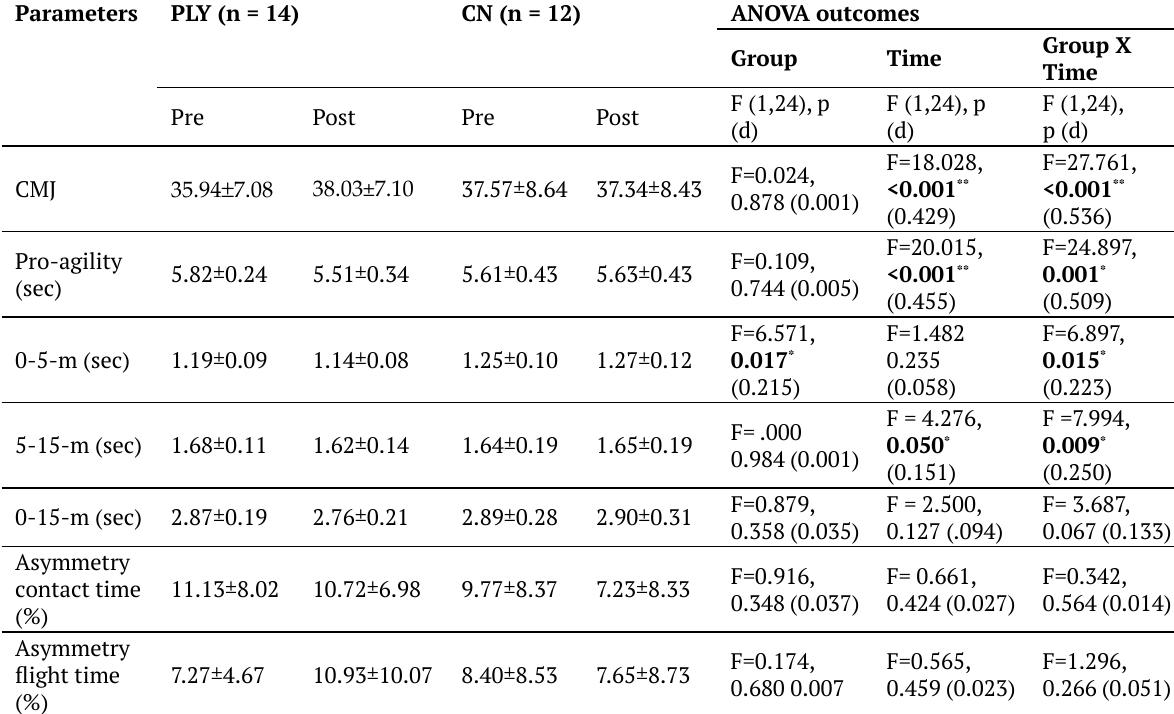
Table 3. Mean and SD of the outcome measures for each group before (pre) and after (post) the intervention